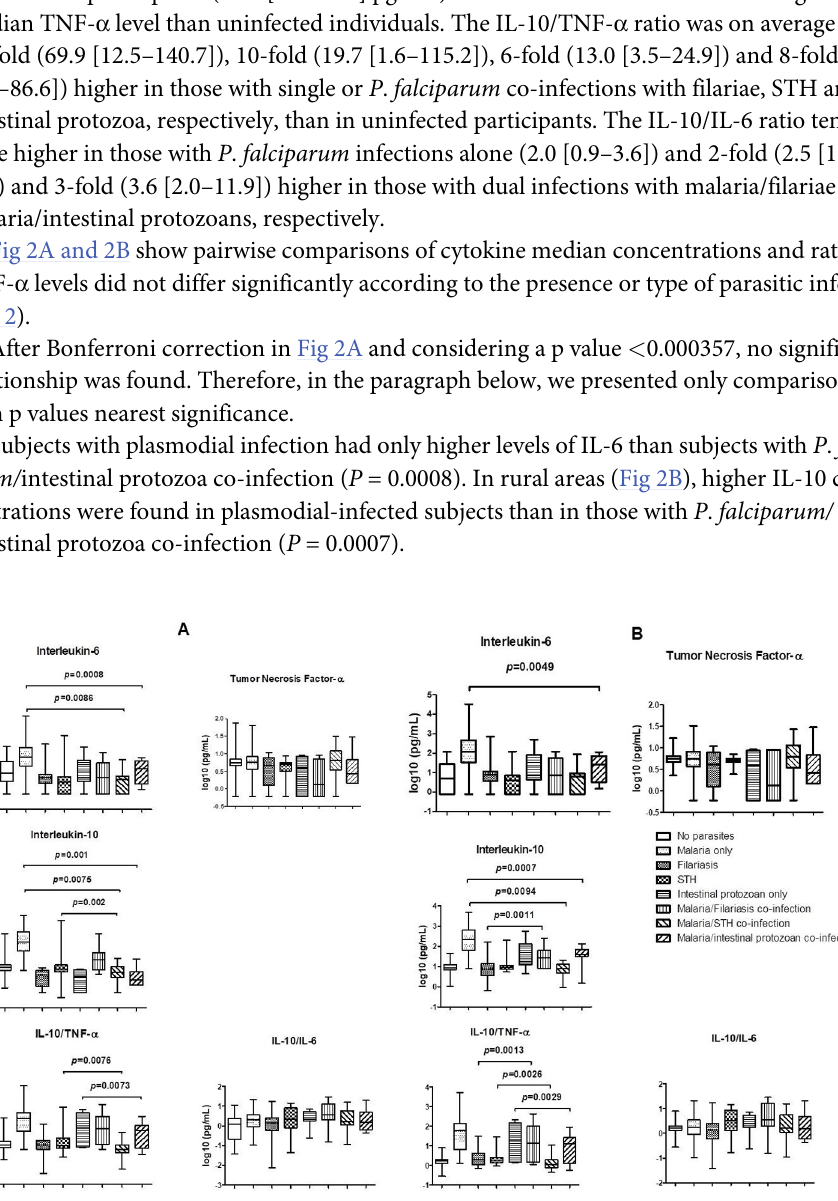
Fig 2. Comparisons of cytokine concentrations between groups with different parasitic profiles. The p value considered significant for analysis presented in this graphic is 0.000357. Only p values with two or more zero after the full stop of the decimal part were presented in the figure. All the associations showed no significant difference. (A) Box plot displaying IL-6, TNF- α and IL-10 cytokine production and IL-10/TNF- α and IL-10/IL-6 median ratios according to different parasitic profiles. The Mann–Whitney test was carried out for pairwise comparisons. Values used for the graphical representation were log-transformed. (B): Comparisons in rural areas only because there were not enough data for urban areas to perform this